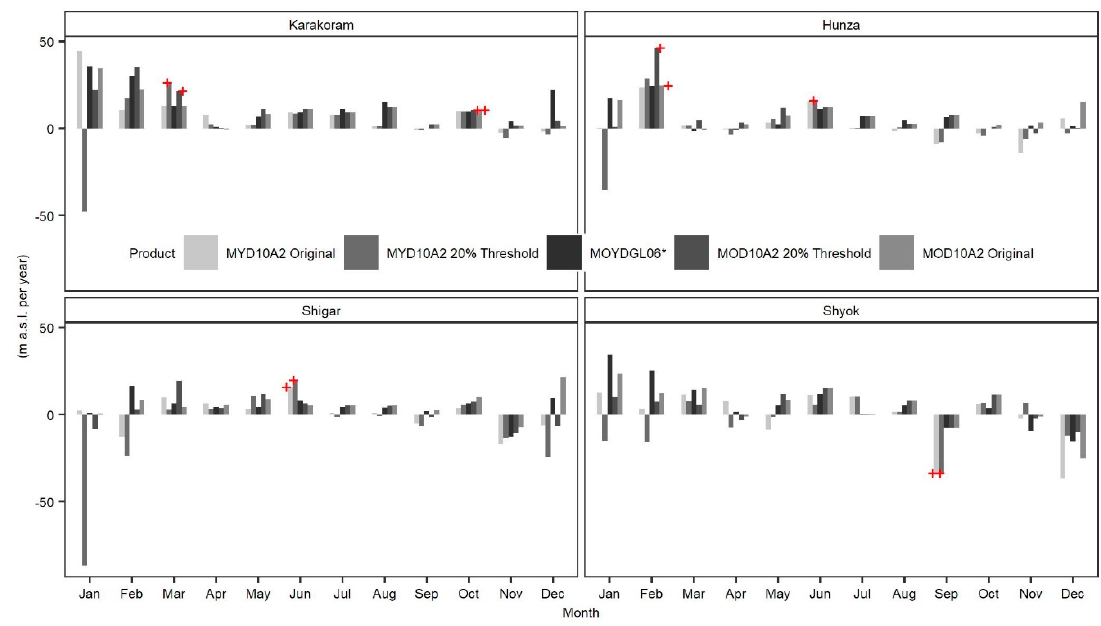
Figure 8. Bar plot illustrating monthly SLA trend. Bars with plus signs represent a statistically significant trend at the 90% confidence level.